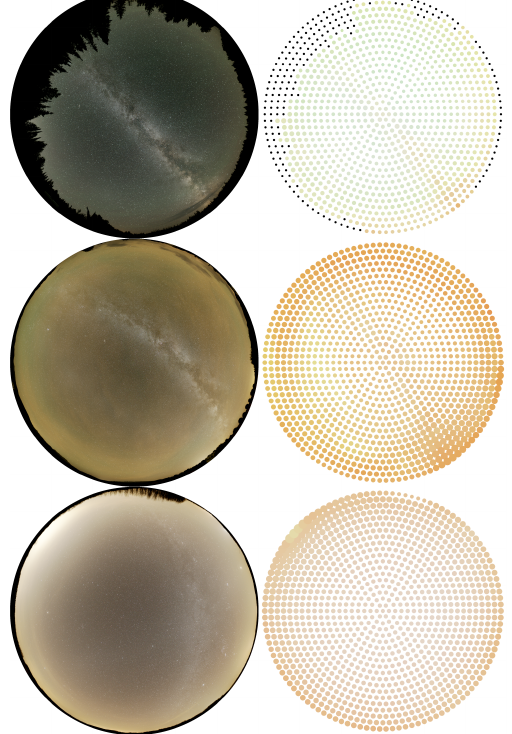
Figure 3. All-sky images and and their colour